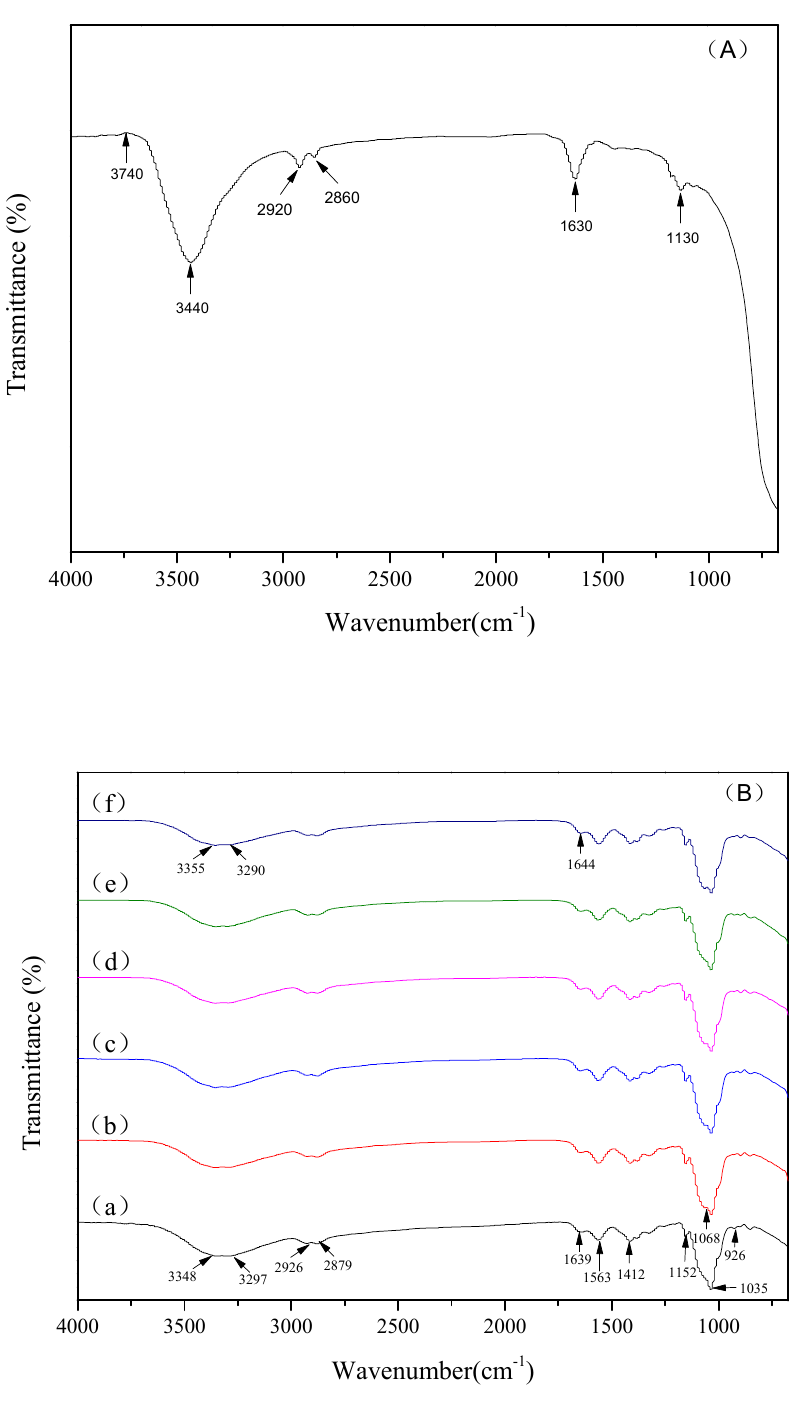
Figure 7. Fourier transform infrared spectroscopy (FTIR) spectra of original TiO 2 nanoparticles ( A ) and chitosan-based coating with different concentrations of TiO 2 nanoparticles ( B ) (a: 0; b: 0.01%; c: 0.03%; d: 0.05%; e: 0.07%; f: 0.09%).